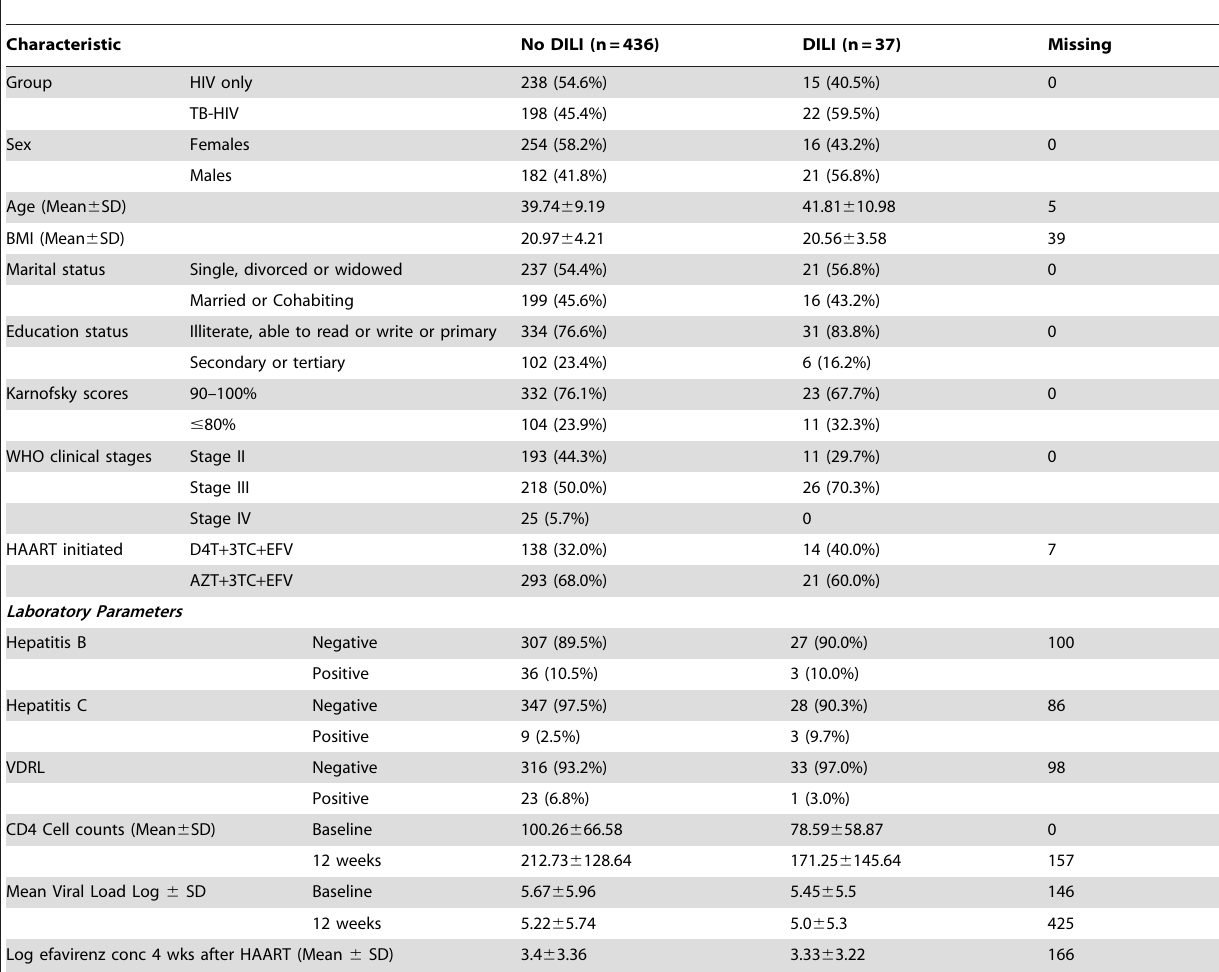
Table 1. Description of demographic and baseline laboratory characteristics of patients with and without DILI.